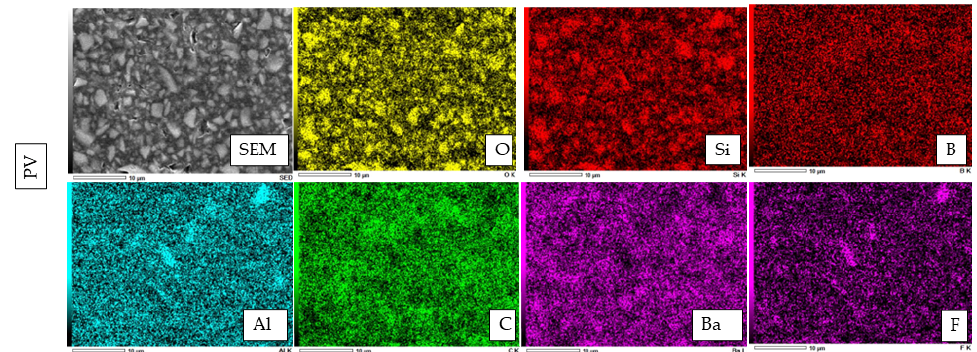
Figure 7. The representative EDX evaluation image of PV at ×3000 magnification. The electron image for EDX analysis of PL shows a wide distribution of seven important elements, including oxygen (O), silicon (Si), boron (B), aluminum (Al), carbon (C), barium (Ba), and fluorine (F).